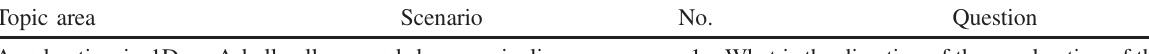
TABLE I. Selected questions